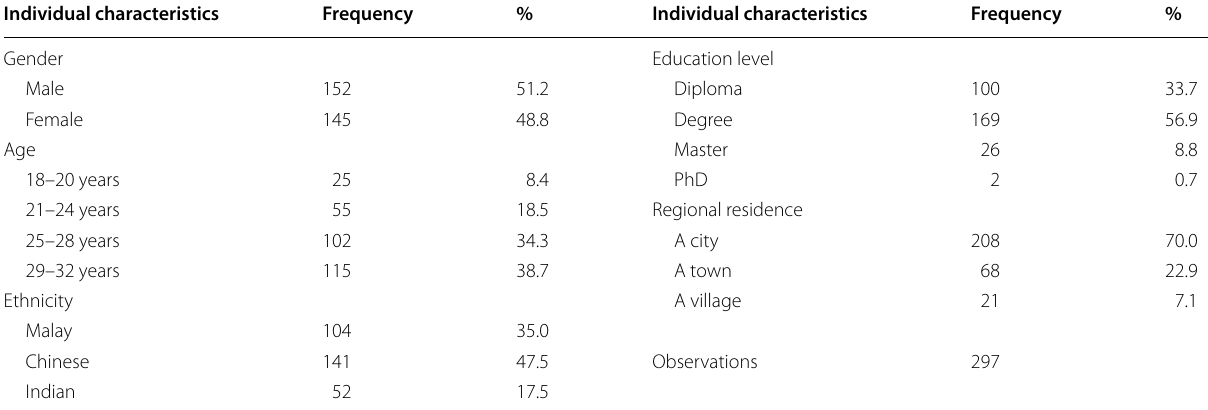
Table 2 Demography of respondents